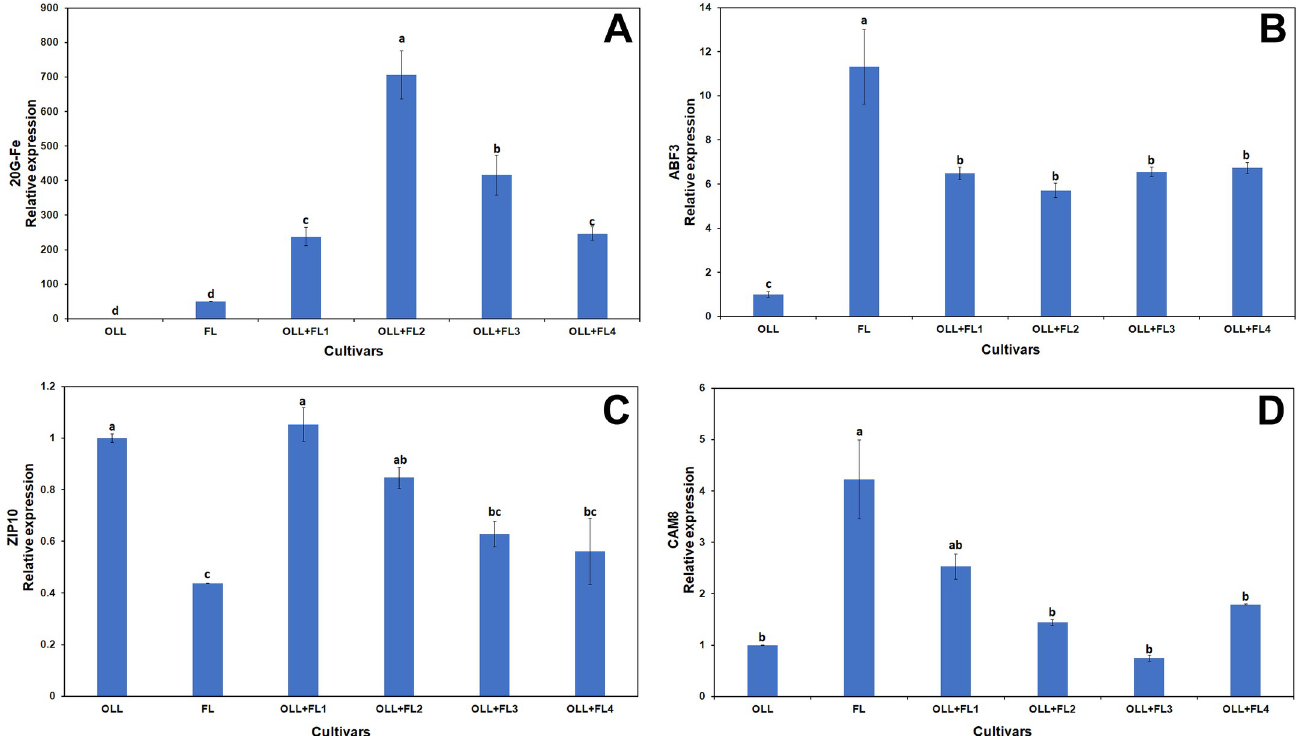
Fig 7. Relative expression of 20G-Fe (A), ABF3 (B), ZIP10 (C) and CAM8 (D) transcripts in OLL8, finger lime (FL) and four selected OLL8+FL allotetraploids. Bars represent means ± standard error. Means separation by Tukey’s honestly significant difference test (P � 0.05).